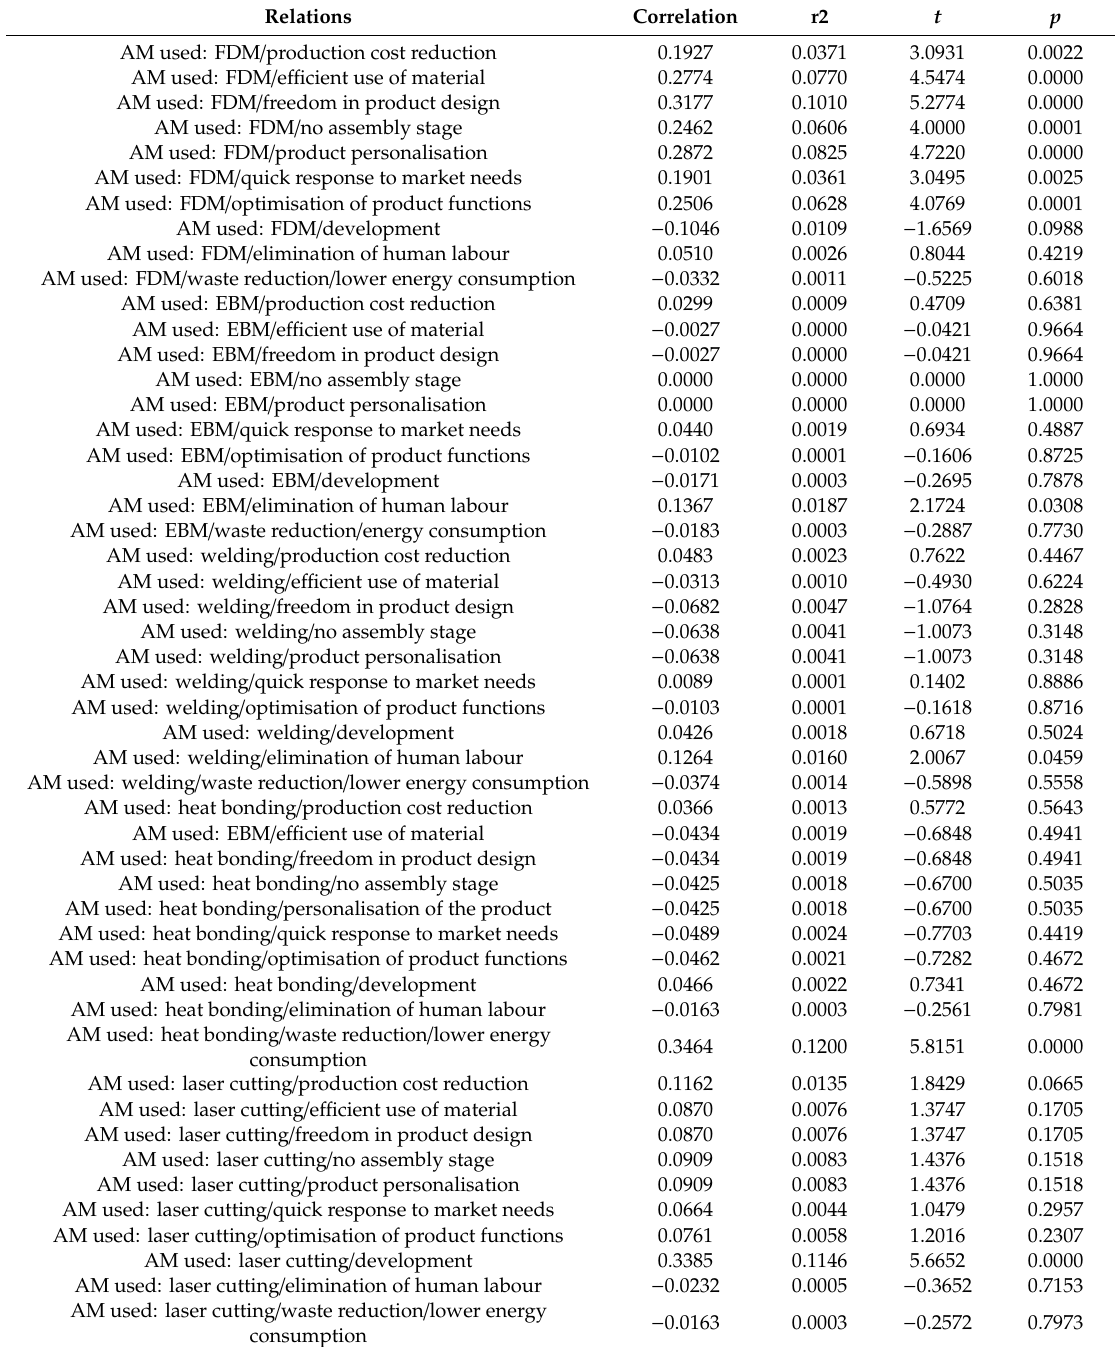
Table 2. Correlation